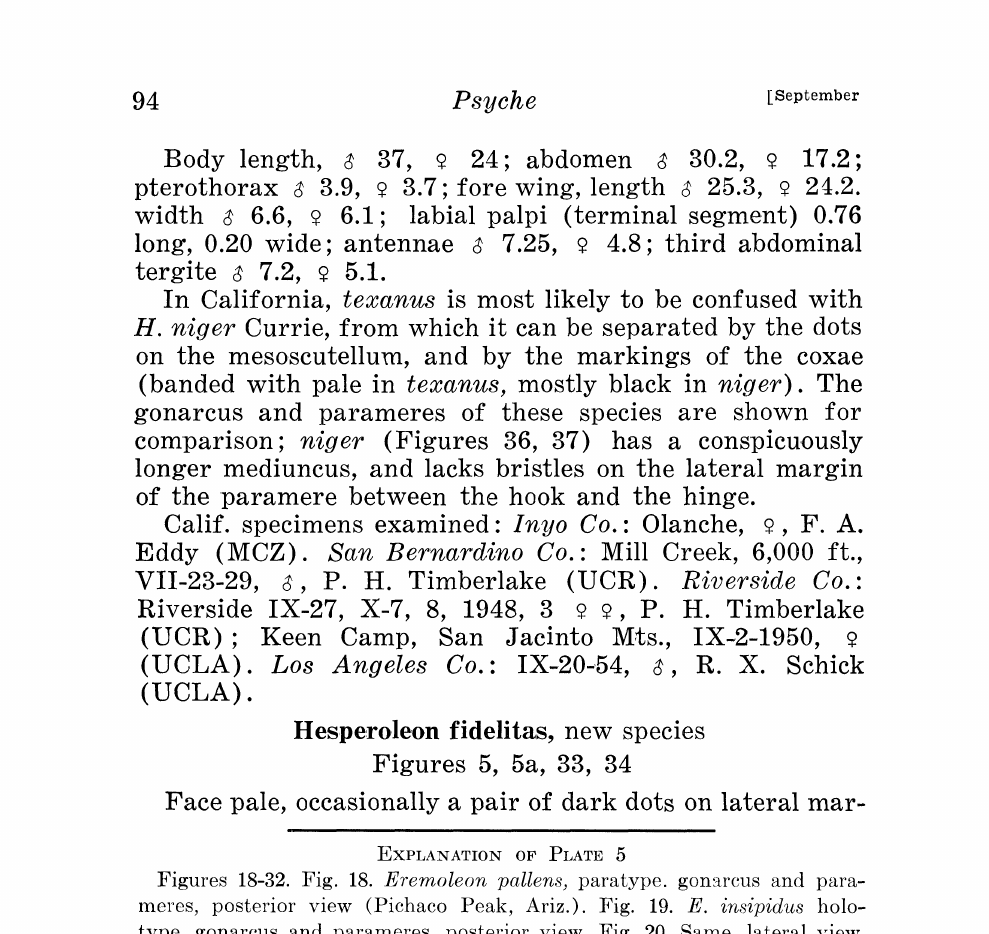
Figures 18-32. Fig. 18. Eremoleon pallens, paratype, gonrcus and para- meres, posterior view (Pichaco Peak, Ariz.). Fig. 19. E. insipidus holo- type, gonarcus and parameres, posterior view. Fig. 20. Same, lateral view. Fig. 21. E. macer, gonarcus and parameres, posterior view (Cuernavaca, Mexico). On the right is shown a portion of the characteristic cobble- stone sculpture on the surface of these plates in Eremoleon. Fig. 22. E. longior, paratype, gonarcus and parameres, posterior view (Xtoloc Cenoto Cave, Chitzen Itza. Yucatan). Fig. 23. Same, lateral view. Fig. 24. E. nigribasis, gonarcus and parameres, posterior view (Tucson, Ariz.). Fig. 25. E. longior, tip of right labial palpus (same specimen as Fig. 22). Fig. 26. E. pallens, paratype, 3, tip of right labial ppus. Fig. 27. E. nigri, basis, 3, tip of right labial palpus (Douglas, Ariz.). Fig. 28. E. insipidus, tip of right labial palpus, holotype. Fig. 29. E. gracile, holotype tip, of right labial palpus. Fig. 30 E. macer, 3, tip of right labial palpus (same specimen as Fig. 21). Fig. 31. Hesperoleon de]lexus, holotype, gonarcus and parameres (everted)’, dorsal view. Fig. 32. Same, lateral